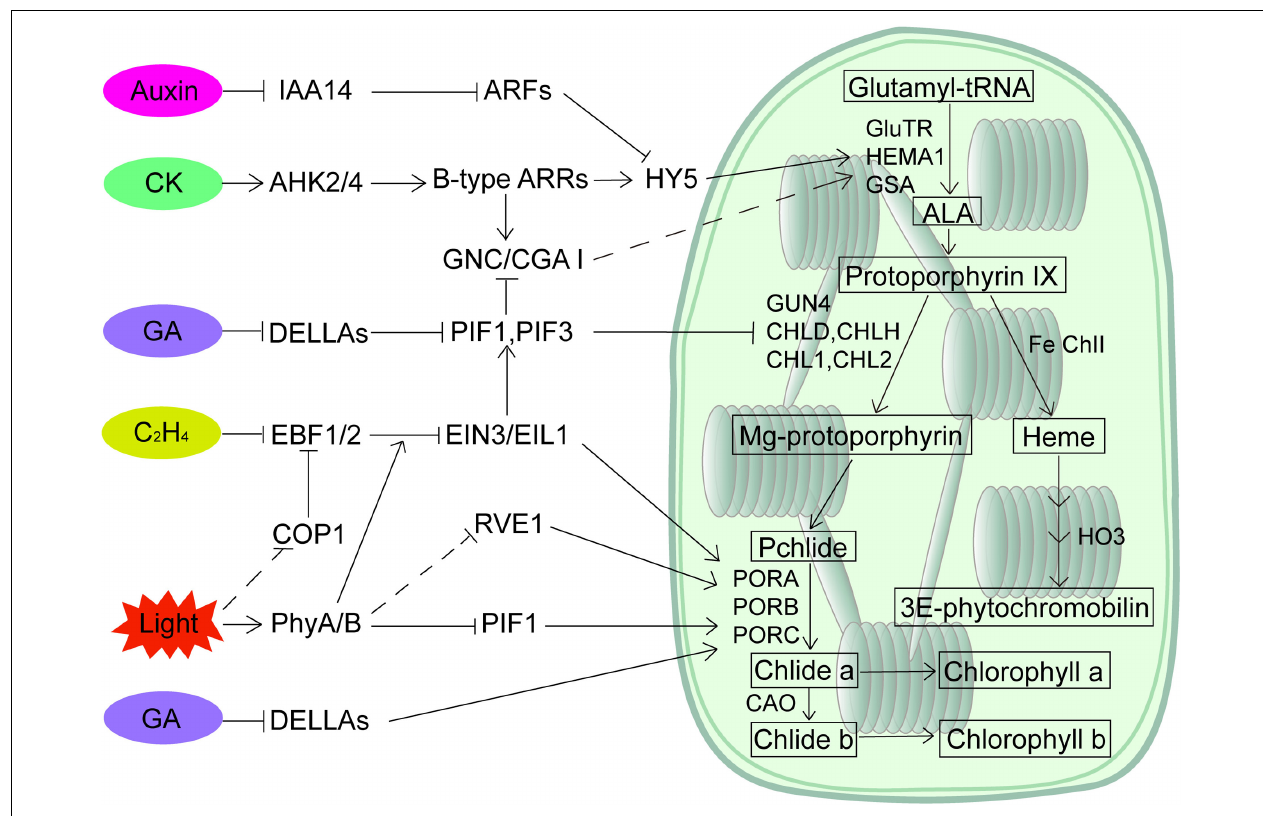
FIGURE 1 | A regulatory network of chlorophyll biosynthesis by light and plant hormones. PIFs and HY5 are major transcription factors in mediating light-regulated chlorophyll biosynthesis. Multiple hormones participate in chlorophyll biosynthesis through both transcriptional and post-transcriptional regulation of PIFs and HY5, while light regulates the action of key components such as EIN3/EIL1 in hormone signaling pathways to modulate the hormonal